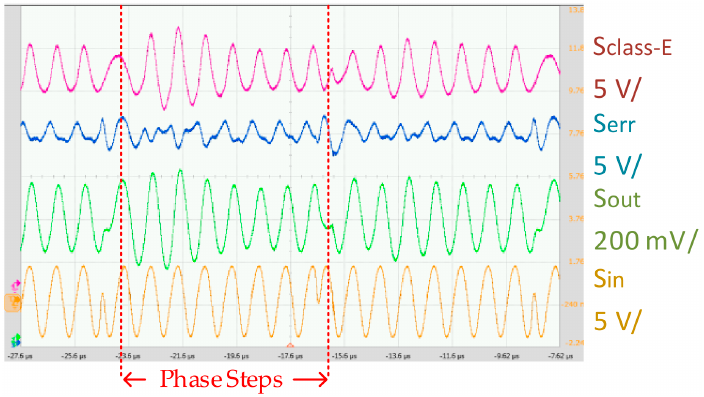
Figure 14. Communication waveforms of the linear-assisted transmitter.